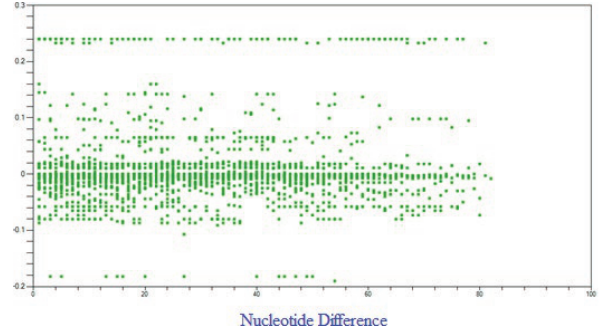
Figure 10. The nucleotide difference in ITS sequences among Avi- cennia species.